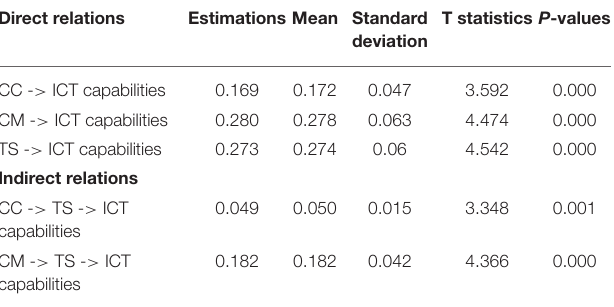
TABLE 7 | Direct and indirect relations. Direct relations Estimations Mean Standard